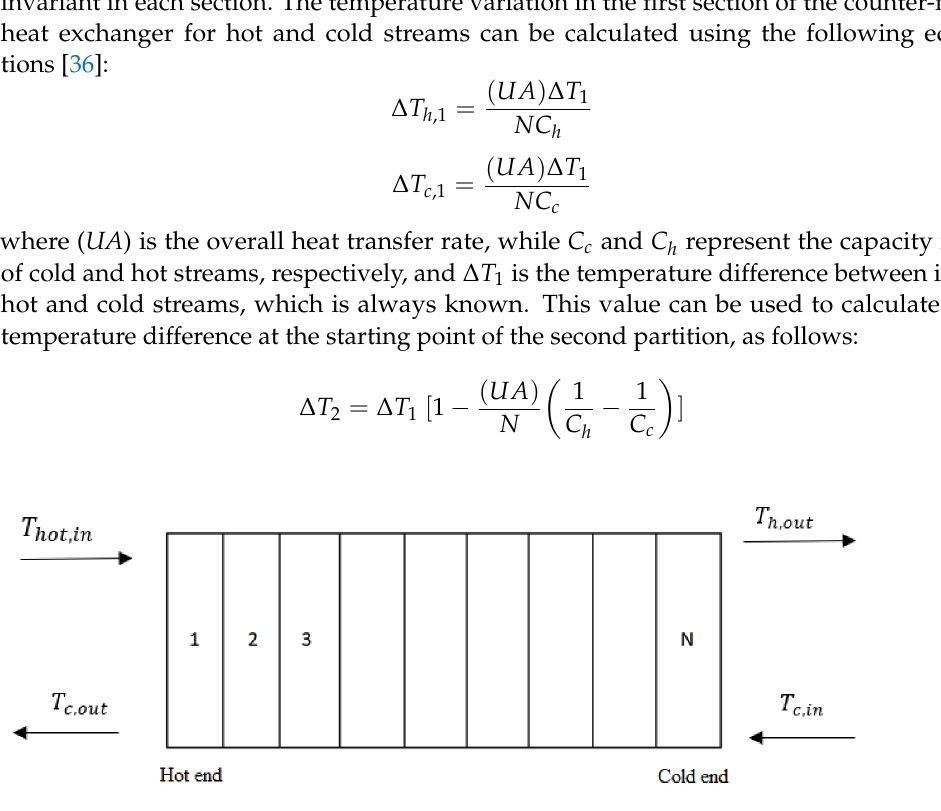
Figure 4. Discretization of a counter-flow heat exchanger into N sections for temperature calculation using the differential method.